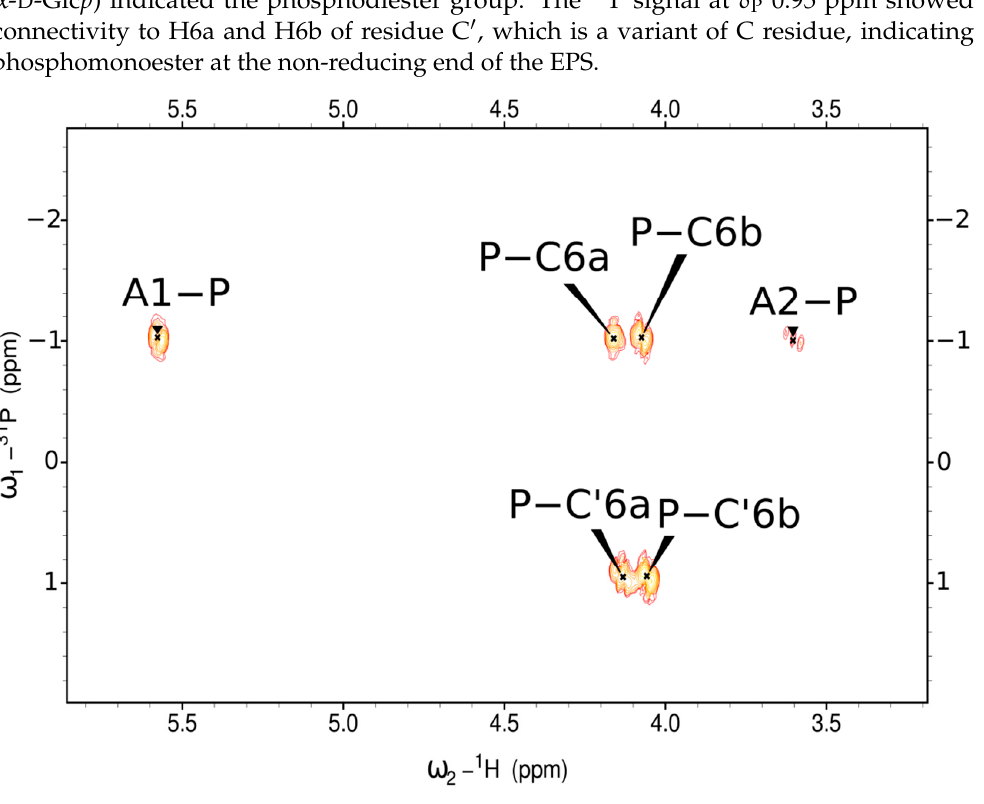
Figure 3. Selected region of 1 H, 31 P HMBC spectrum of the EPS.